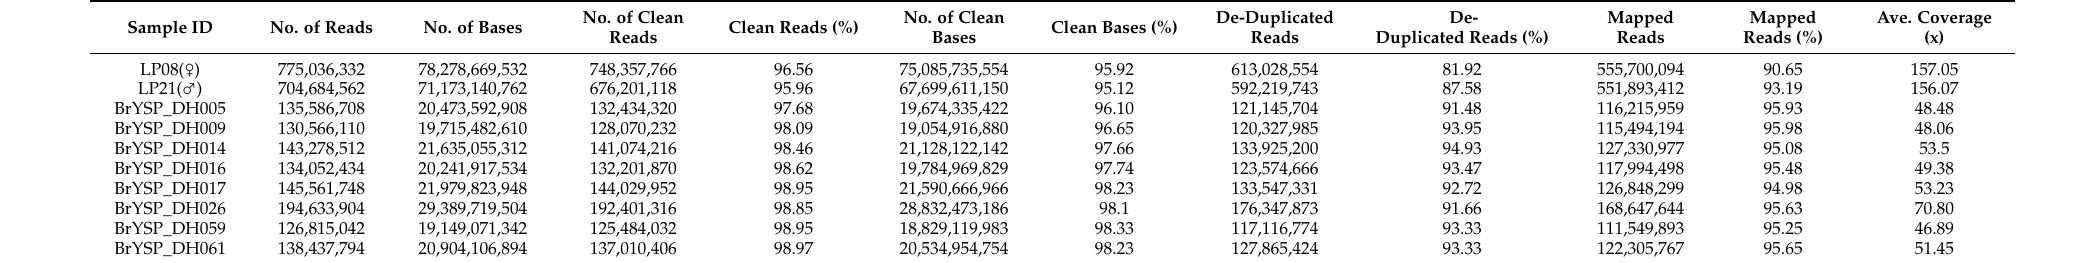
Table 2. Summary of re-sequencing and alignment result for DH lines of Brassica rapa .